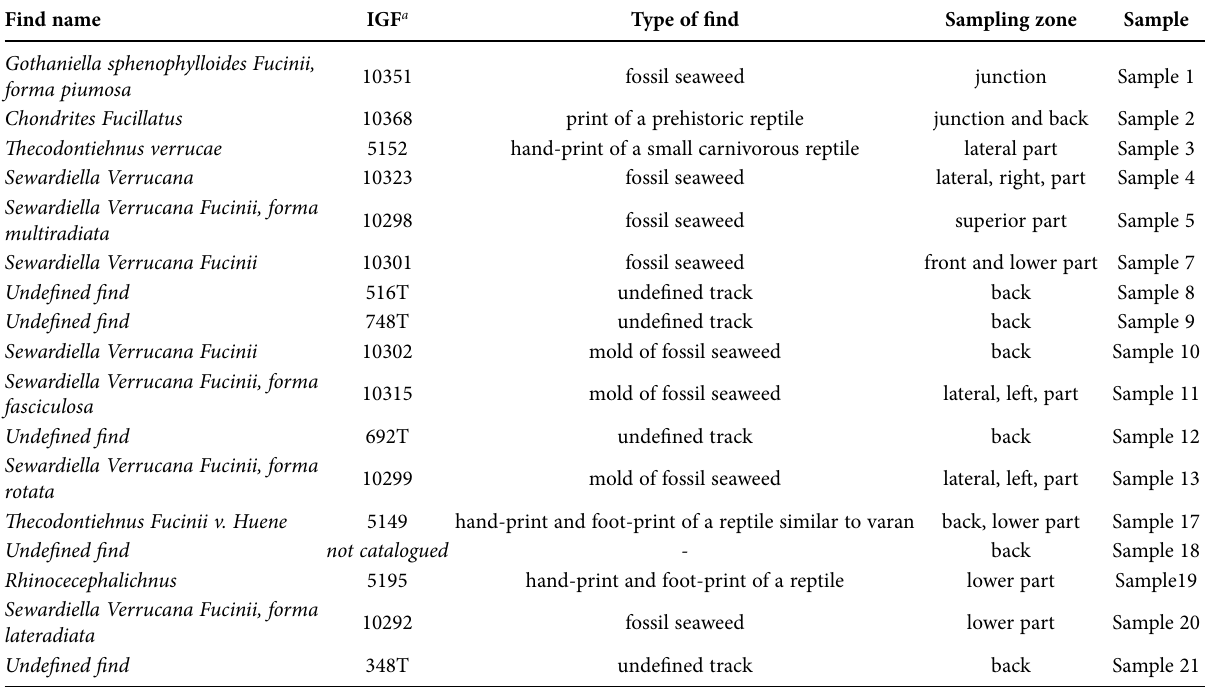
Table 1. Finds and